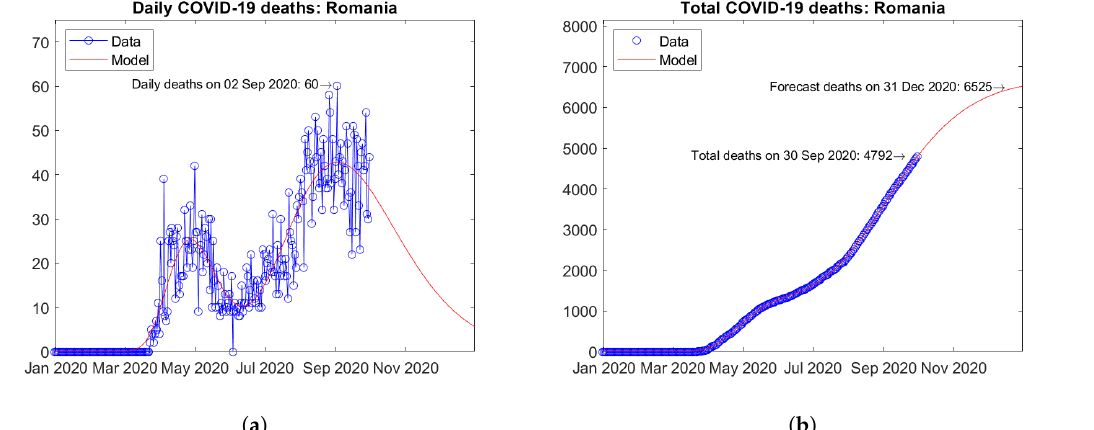
Figure 12. Actual and predicted trends in Romania: ( a ) daily deaths, ( b ) total deaths.